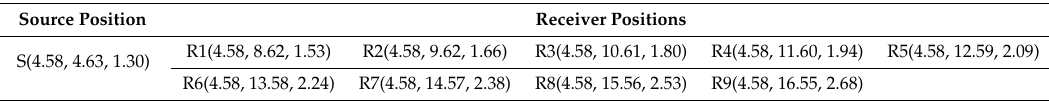
Table A1. Source and receiver positions for measurements at di ff erent source–receiver distances corresponding to Figure